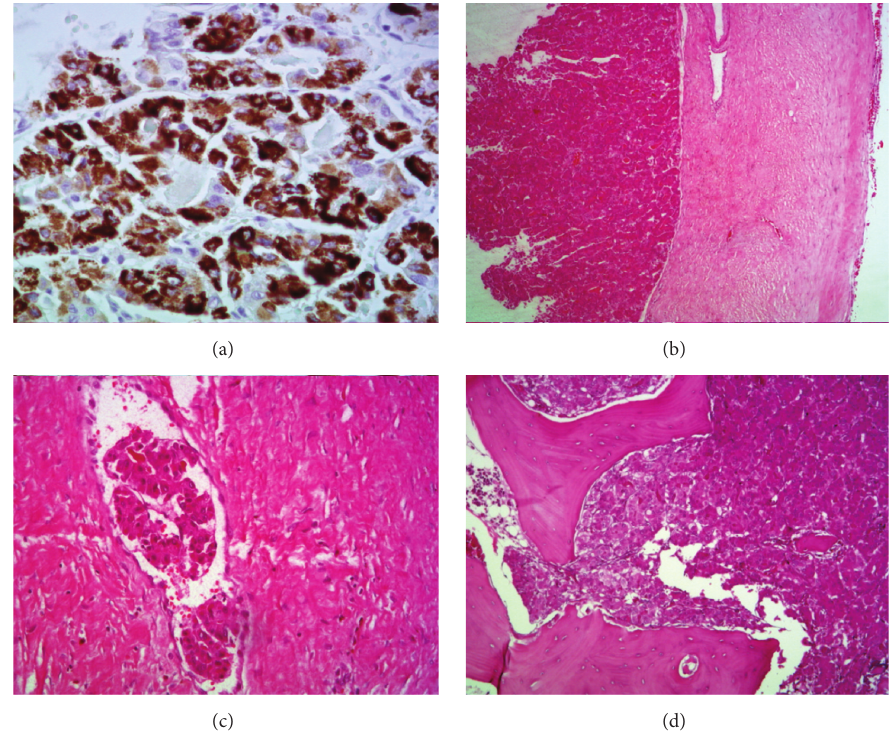
Figure 2: Photos of the hepatocarcinoma pathological structures and MRI image. (a) Hepatocyte. Typical hepatocellular carcinoma cells. 200x. (b) H/E. Tumor cells on the left and intact dura mater on the right. 25x. (c) H/E. Clumps of tumor cells within vascular spaces, demonstrating the tumor bloodstream dissemination. 100x. (d) H/E. Typical hepatocellular carcinoma.